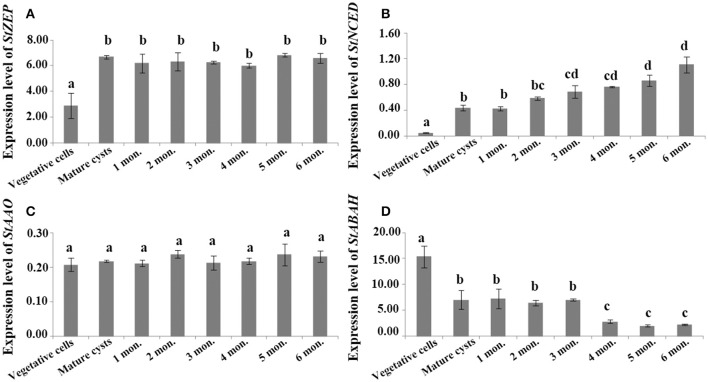
The transcript levels of genes associated with ABA biosynthesis and catabolism, (A)
StZEP
(B)
StNCED
(C)
StAAO
(D)
StABAH, relative to MDH (reference gene) in resting cysts stored at 4 ± 1°C in darkness for different periods of time (0–6 month). The Y axis shows the expression levels of targeted genes relative to the reference gene; Significant differences are presented with different letters above bars at p < 0.05; same letter denotes no significant difference. Values are presented as mean ± standard deviation, Error Bars = SD, n = 3.